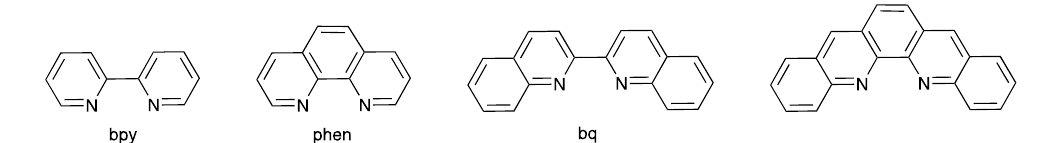
Scheme 1. Structures of 2,2'-biquinoline (bq) and dibenzo[b,j][1,10]phenanthroline compared to bpy and phen.